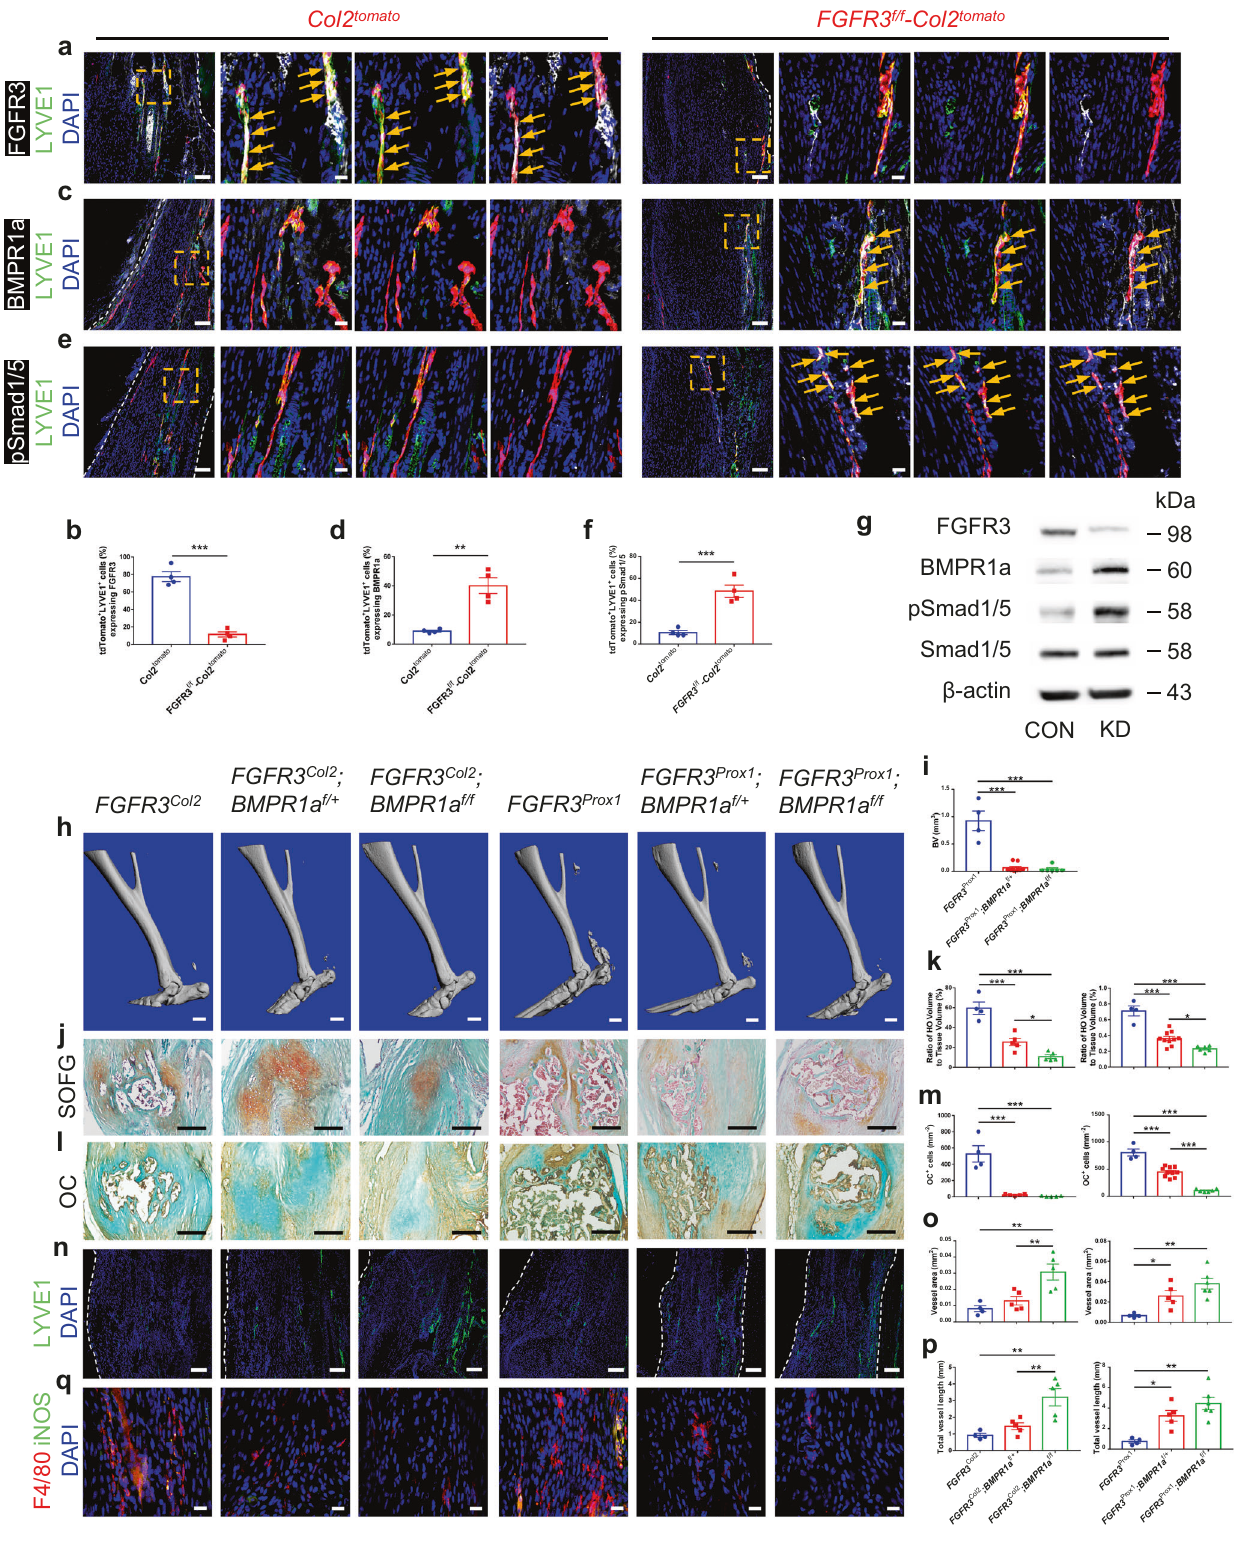
chondrogenesis coupled with type H vessel formation during HO development. It is plausible that the heterogeneous Nestin + cells provide both mesenchymal progenitors contributing to HO for- mation and endothelial progenitors involving in angiogenesis 3 . Previous study revealed that Col2 + cells encompass mesenchymal progenitors that give rise to chondrocytes, osteoblasts,